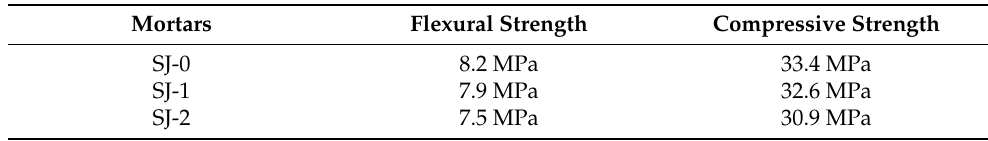
Table 4. Flexural strength and compressive strength of mortars.